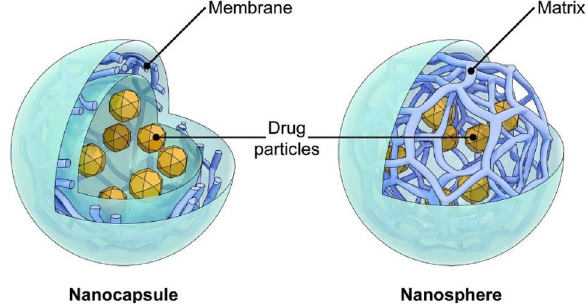
Fig. 3 A representation of the structure of a nanocapsule and a nanosphere. The image is in the public domain and is credited to the National Institutes of Health/Department of Health and Human Services